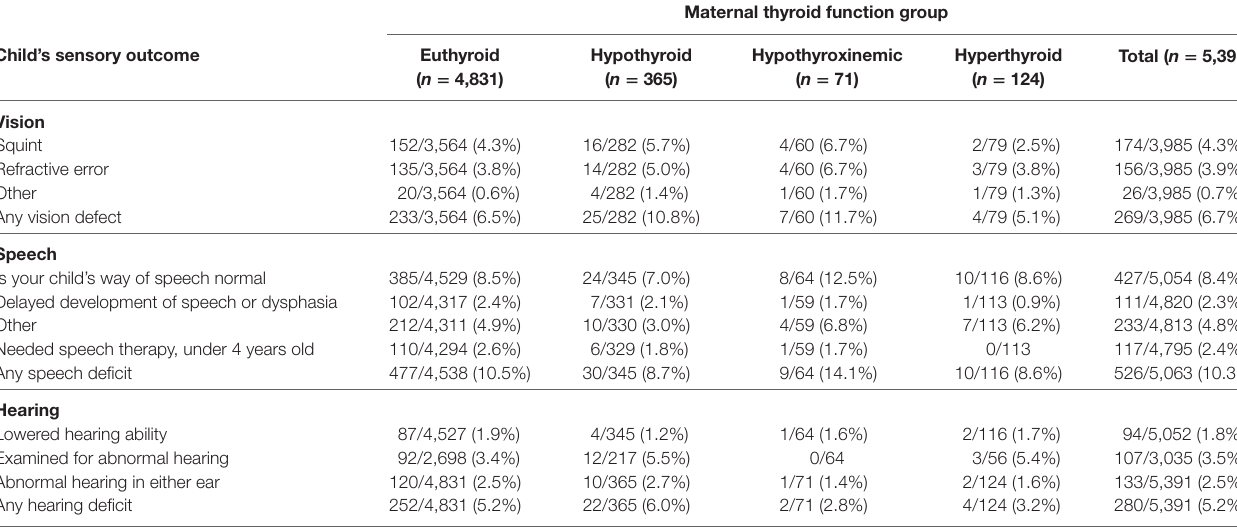
Maternal thyroid function group